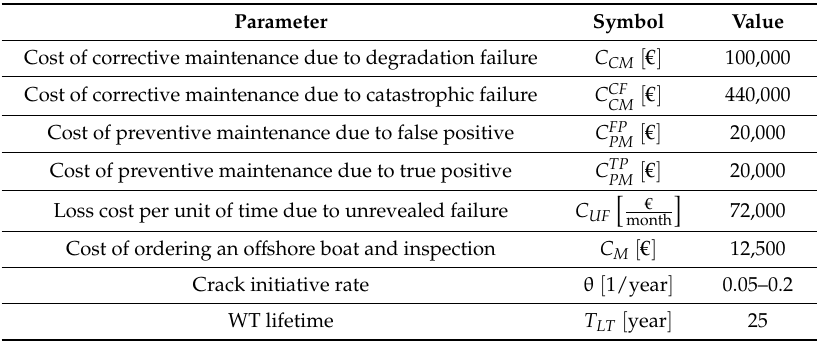
Table 2. Model parameters.